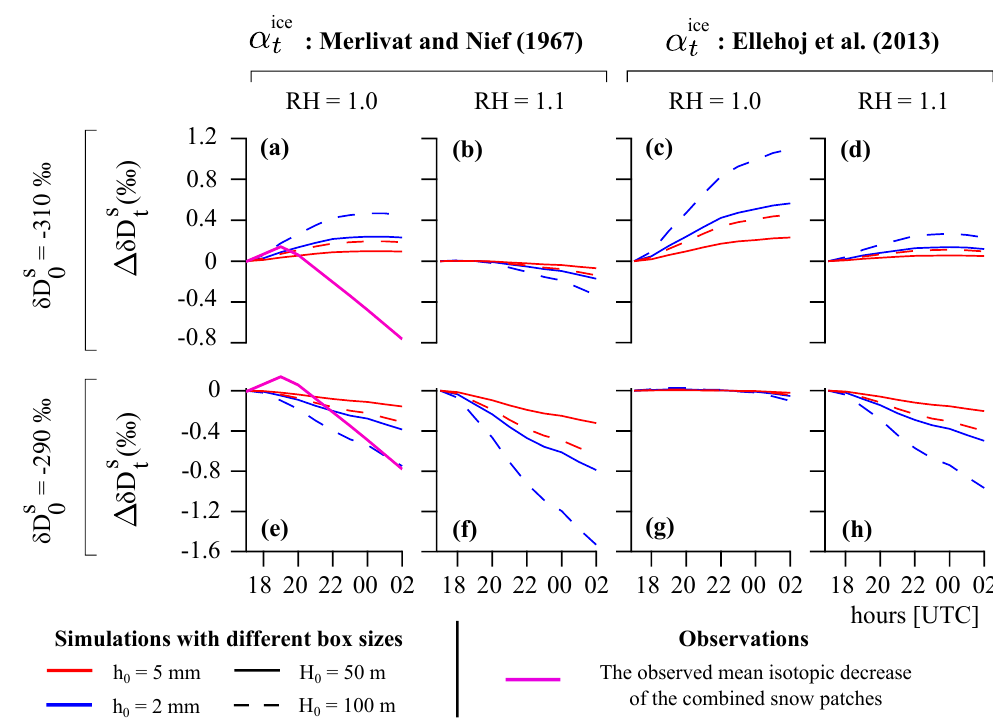
ObservationsSimulations with different box sizes The observed mean isotopic decrease of the combined snow patches Figure 7. Simulated (box model) deuterium anomalies of the snow surface during the cooling phase, with h 0 , H 0 , RH, α t and δ D s as varying 0 inputs parameters. Fractionation coefficients at equilibrium come from Merlivat and Nief (1967) and Ellehoj et al. (2013), calculated with T at 2m. Equivalent fractionation coefficients have been calculated from Jouzel and Merlivat (1984) for RH =